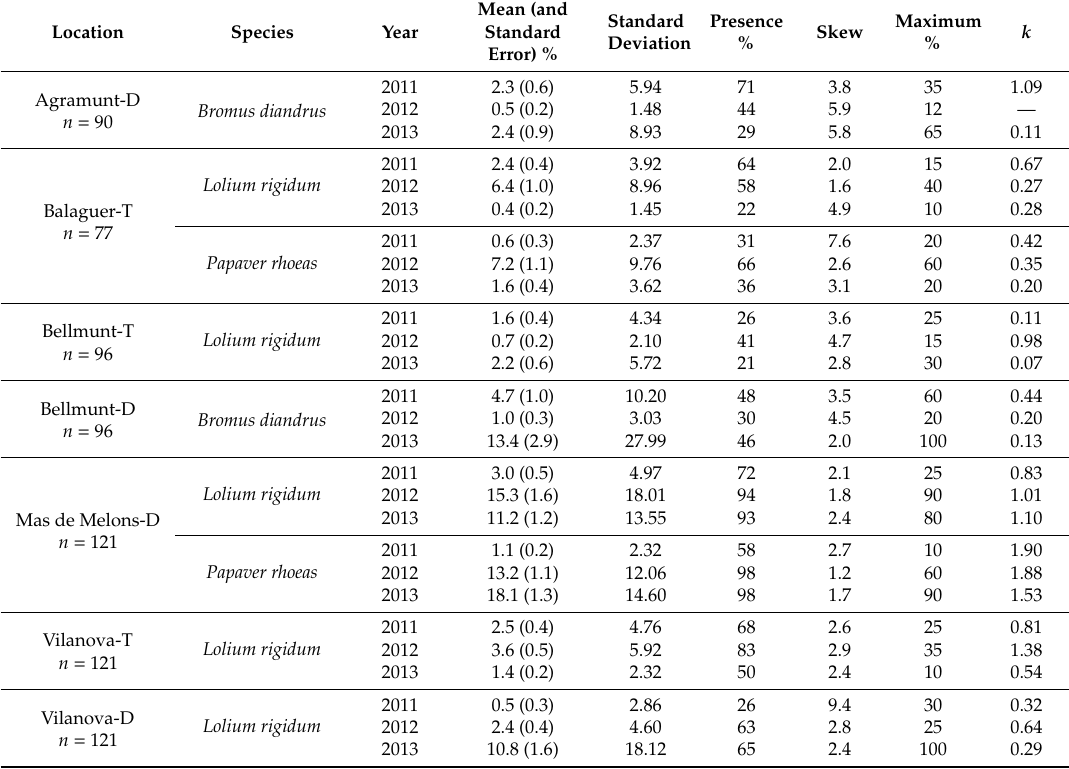
Table 3. Summary statistics for percentage cover (%) of the main weed species in the 50 cm × 50 cm quadrats in each location and year. The number of observations used to calculate each statistic is given by n in the first